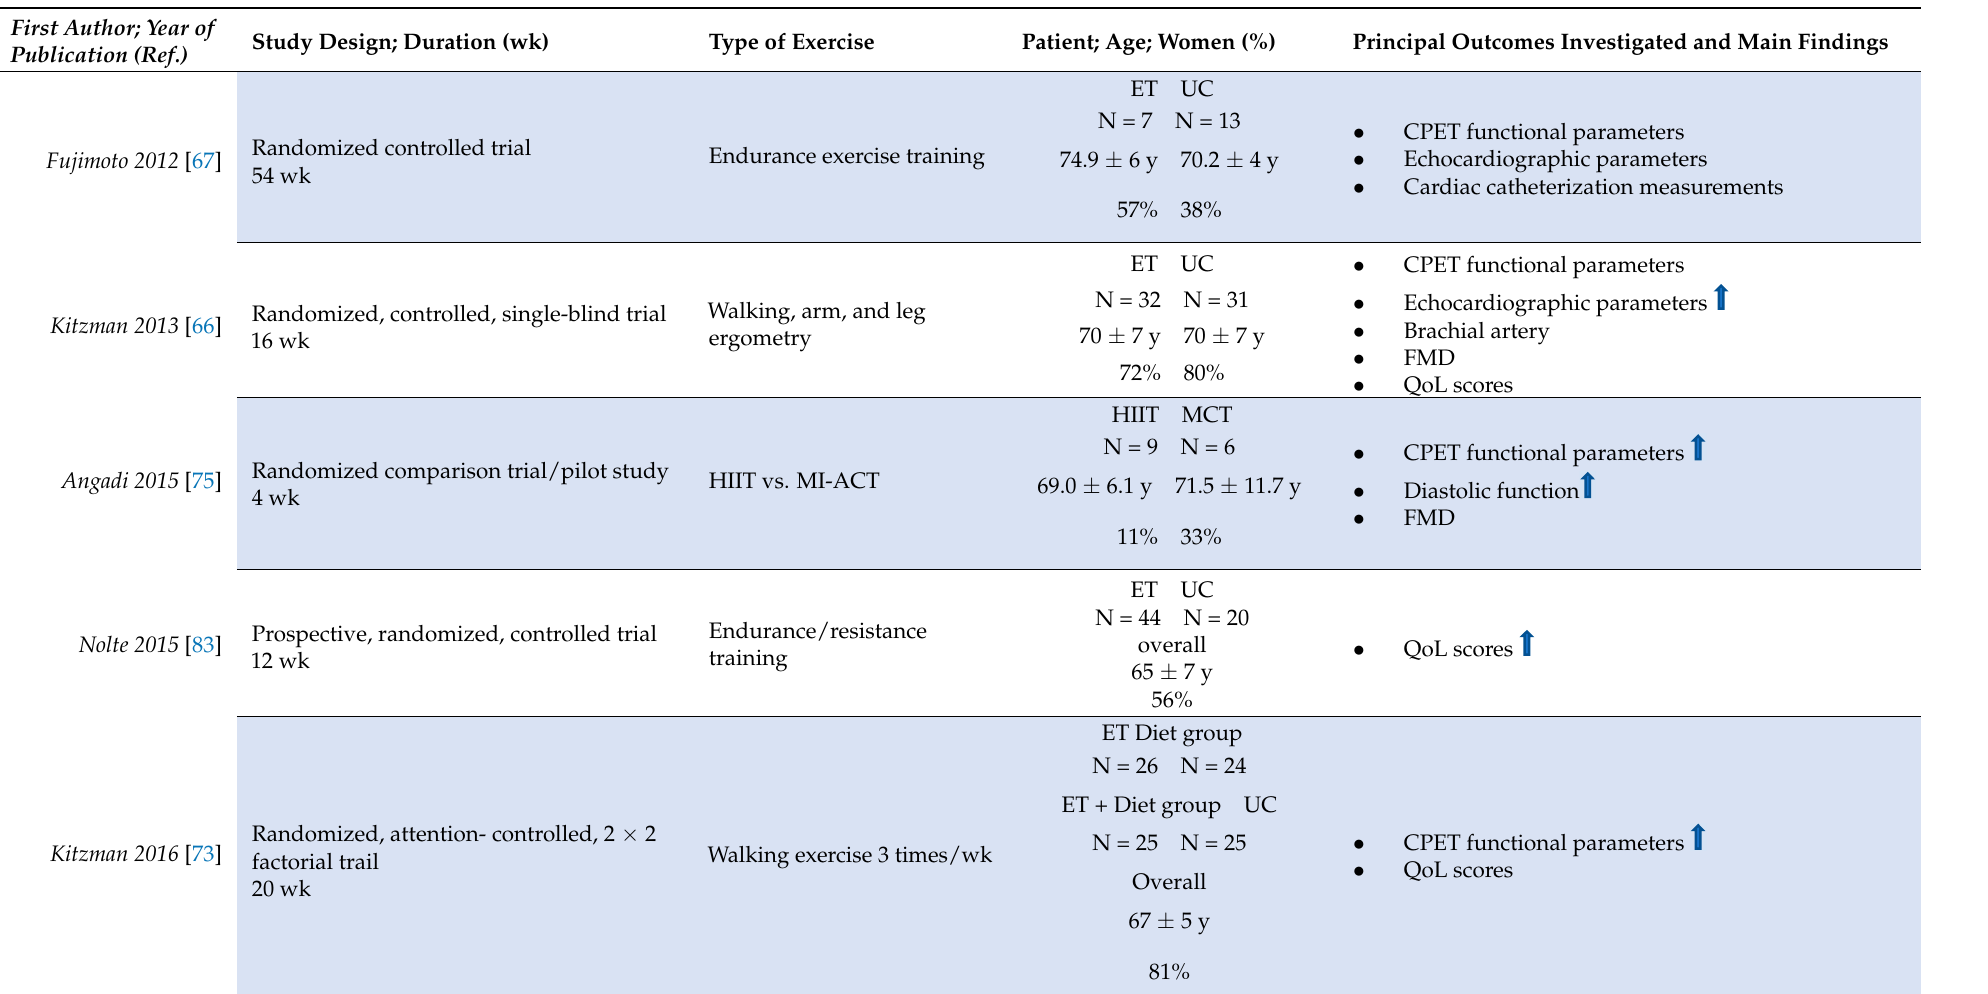
Table 7. List of studies investigating the role of exercise training in patients with preserved ejection fraction.